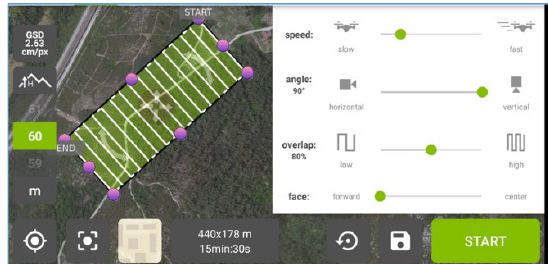
Figure 2 Pix4D App for flight planning